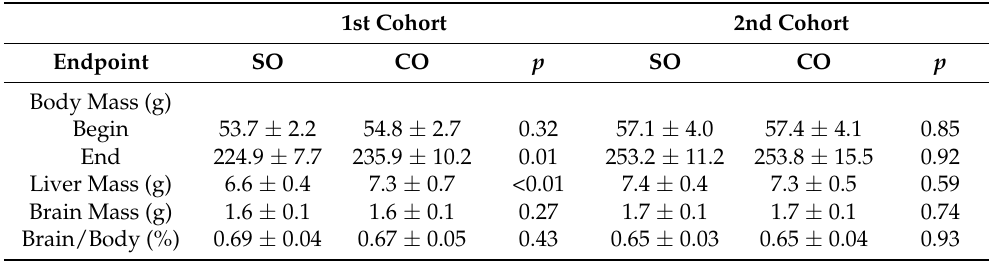
Table 1. Body composition in growing male